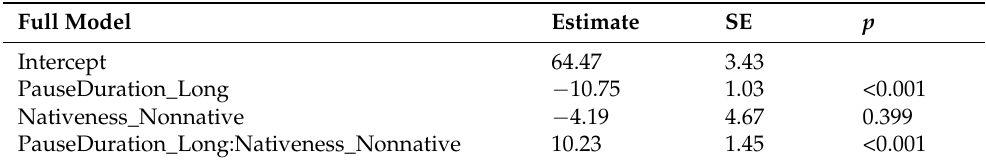
Table 3. Results of the linear mixed model exploring the effects of pause duration and nativeness on perceived willingness to grant requests. The table reports estimated model coefficients (Estimate), standard errors (SE) and p -values ( p